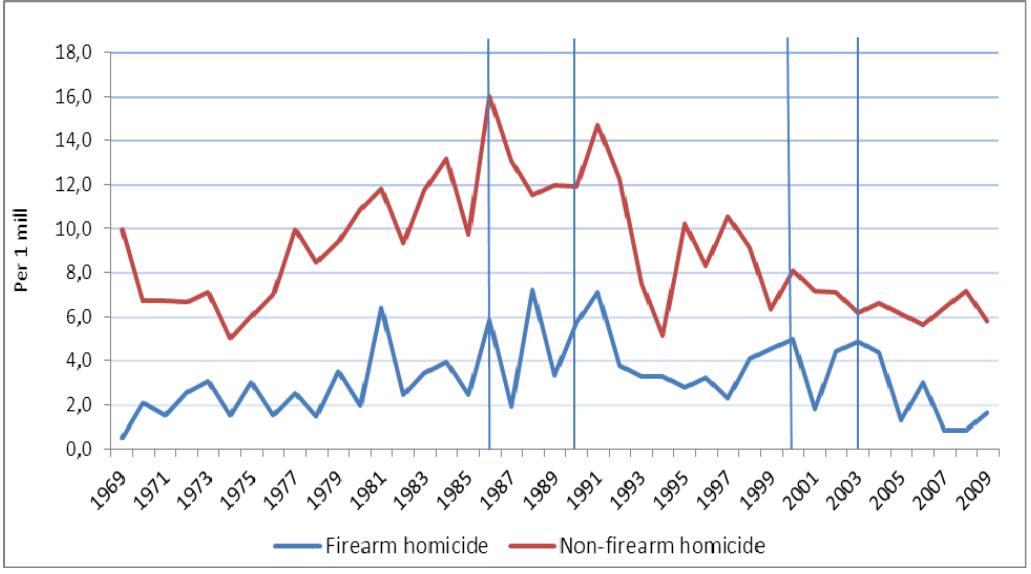
Figure 3. Observed time trends in firearm homicide and non-firearm homicide among males in Norway 1969–2009 (per 1 million). Different pieces of firearms legislation were implemented in 1986, 1990, 2000, and 2003 (vertical